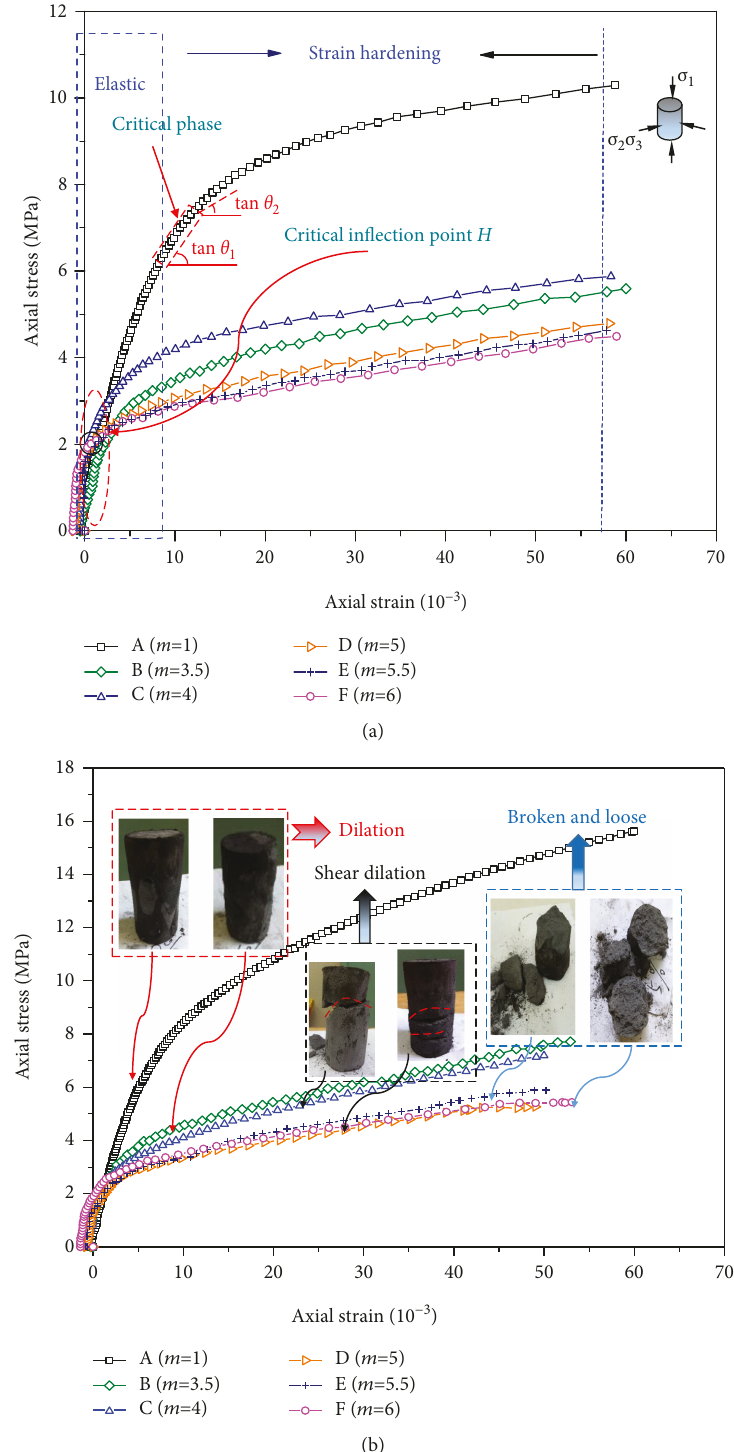
Figure 5: Stress-strain law of the triaxial test under di ff erent con fi ning pressures: (a) 2MPa con fi ning pressure test and (b) 4MPa con fi ning pressure test results and failure modes of